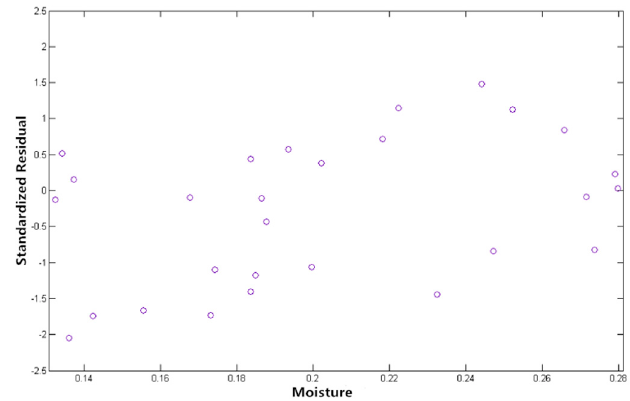
Figure 6. Standardized residuals in the fitting test at 2 kHz.